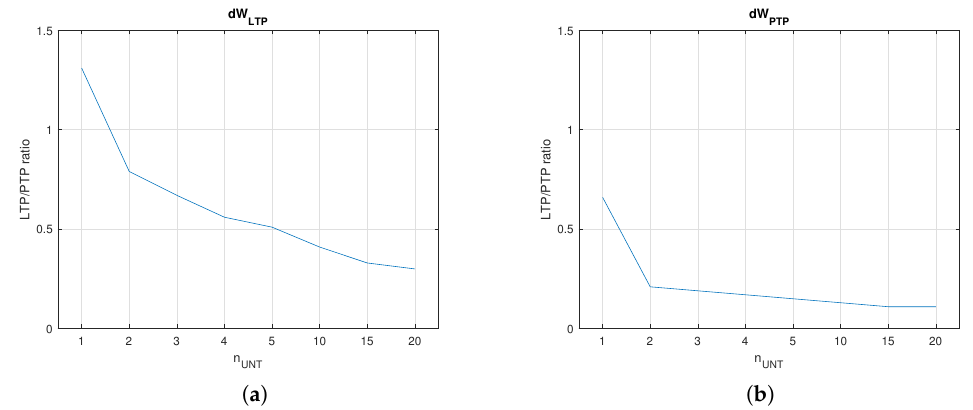
Figure 7. Learning until f POST = 100 Hz when the number of untrained neurons n UNT varied. ( a ) dW LTP and ( b ) dW PTP for f UNT = 50